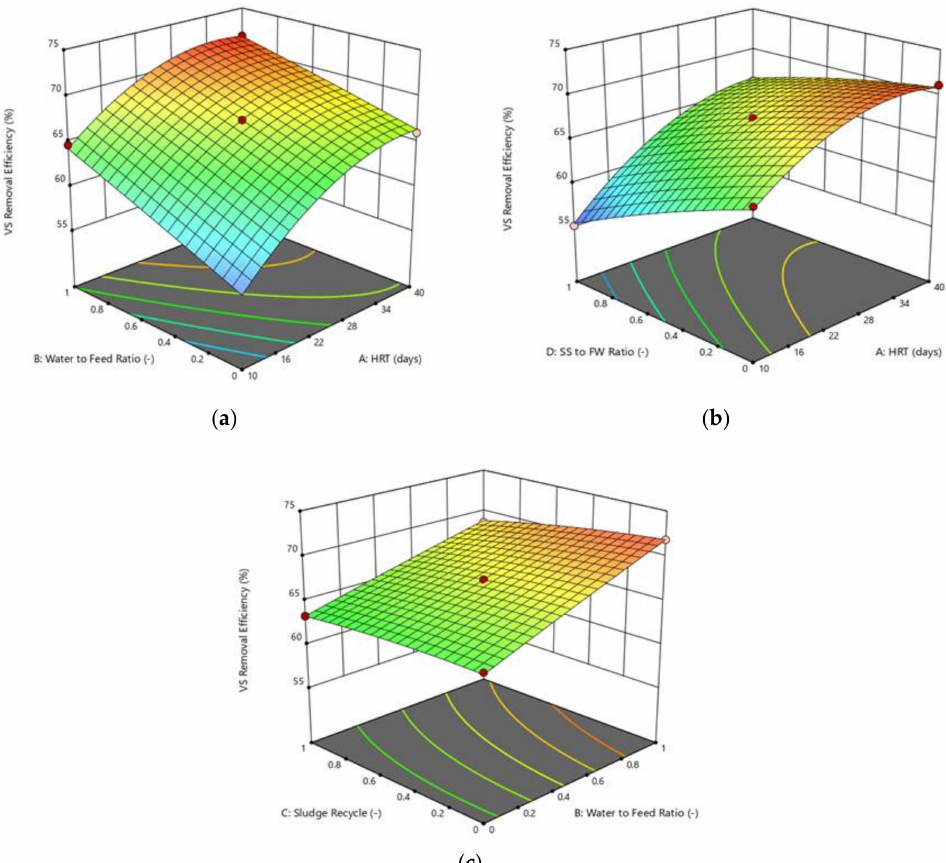
Figure 7. 3D surface graph plot for VS removal efficiency as a function of ( a ) HRT and water to feed ratio; ( b ) HRT and SS to FW ratio; ( c ) water to feed ratio and sludge recycle